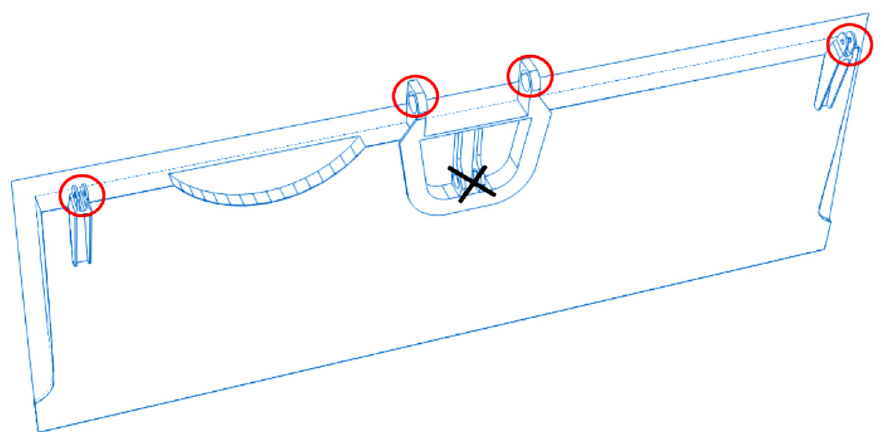
Figure 1. Boundary conditions of the spoiler.